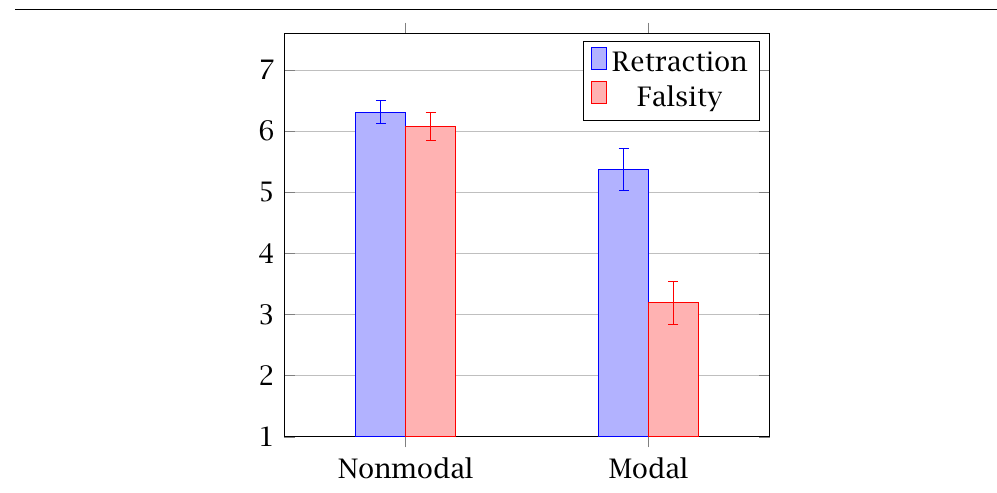
Figure 4 Mean ratings by condition for Experiment 4 . Error bars show standard error of the